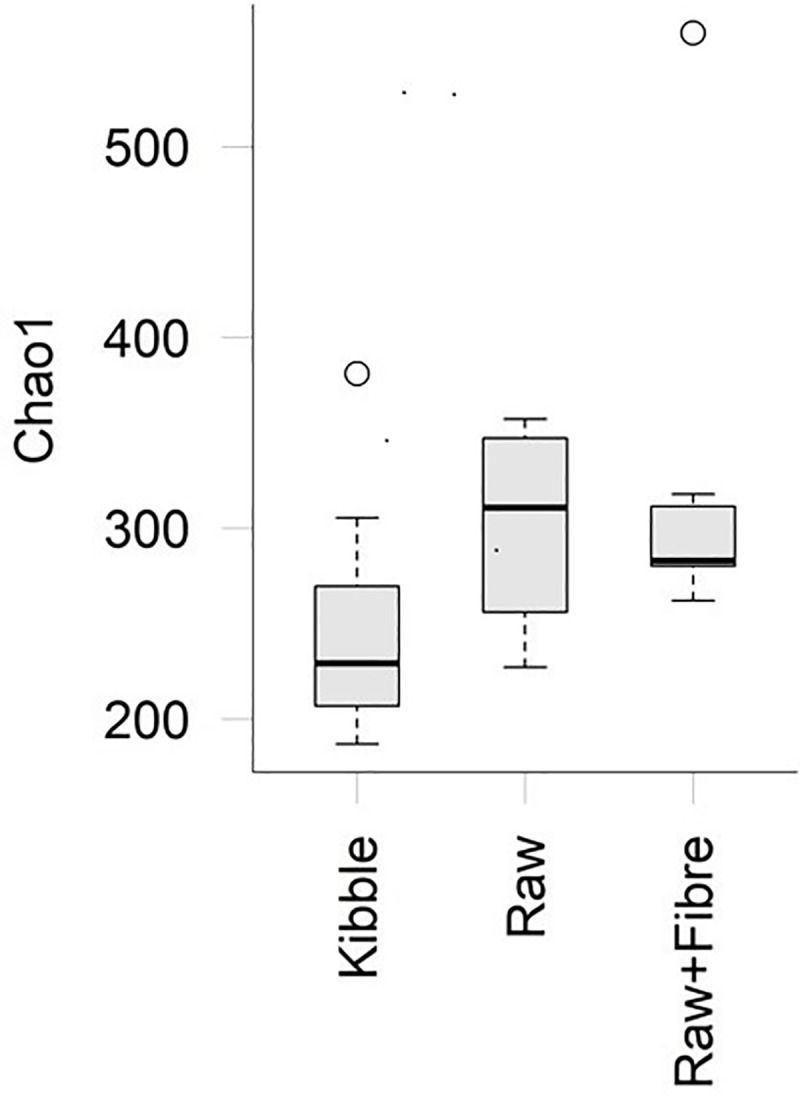
Chao 1 alpha diversity index boxplot.Alpha diversity of bacterial genera from adult domestic shorthair cats fed Kibble, Raw+Fibre and Raw diets. A slight trend (P = 0.08) for a decrease in Chao1 alpha diversity in the Kibble diet was observed. Circles denote outliers.